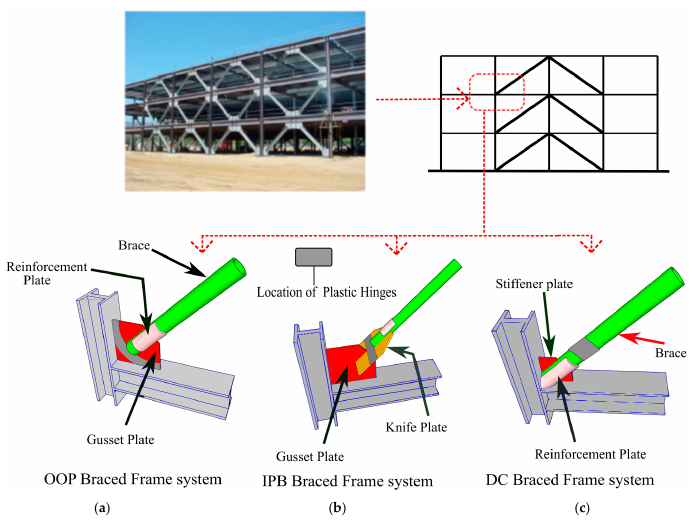
Figure 1. Connection detailing of ( a ) out-of-plane buckling (OOPB), ( b ) in-plane buckling (IPB), and ( c ) direct connection (DC) braced frame systems. 2. Background SCBF structures built after the incorporation of the Uniform Building Code [17] are designed for a ductile response using a capacity-based design method. However, limited knowledge of the performance of its components and their interaction leads to early strength loss. The premature loss of strength of the brace in the particular story accumulates the inelasticity in that story and forms the soft-story mechanism, which finally leads to the structure’s collapse [18]. Hence, the structures need to be designed to avoid premature fracture and to maximize the lateral drift capacity of the brace. Astaneh- Asl et al. [19] first introduced the concept of a tapered gusset plate with linear clearance of twice the thickness of the hinge plate for the restraint-free rotation, which led to the out-of-plane buckling (OOPB) brace system. It was observed that forming hinges on the gusset plate enhances the ductility of the braced frame system. To further improve the performance of the SCBF system, a series of experimental and numerical studies were conducted in the United States, which led to development of a compact rectangular gusset plate arrangement with elliptical clearance [13,20,21]. Research also highlighted the influence of the flexibility of the connection on the ductility of the braced frame system but mostly focused on the OOPB brace system. This also illustrates the balance design procedure that leads to the desired yield hierarchy for the SCBF structures [22]. Roeder et al. [22] investigated the behavior of the gusset plate connections in multi-story X-braced frames and observed that the seismic performance of the braced frame is affected by the design and detailing of the gusset plates.